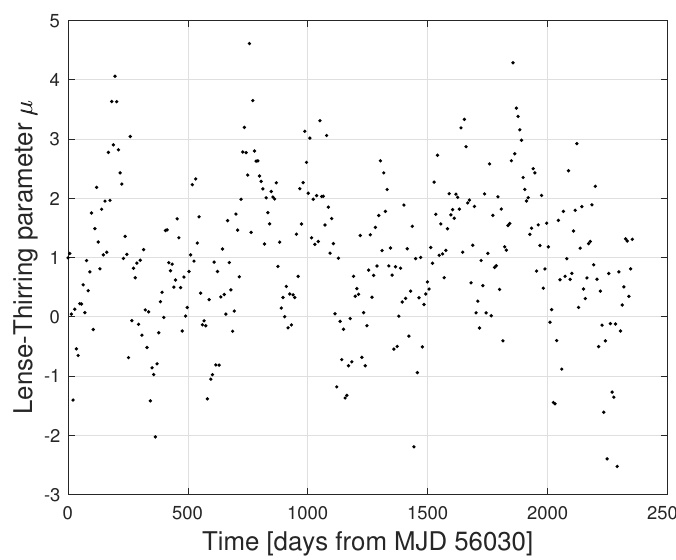
Figure 3. The Lense-Thirring parameter µ estimated, arc by arc, in the time span of our analysis. For the mean value we obtained µ = 0.99 ± 0.13 (at a 95% confidence level). The standard deviation of these residuals is about 1.20; this large value is due to the unmodeled periodic effects. The GGM05S model was considered for the background gravitational field of the Earth.